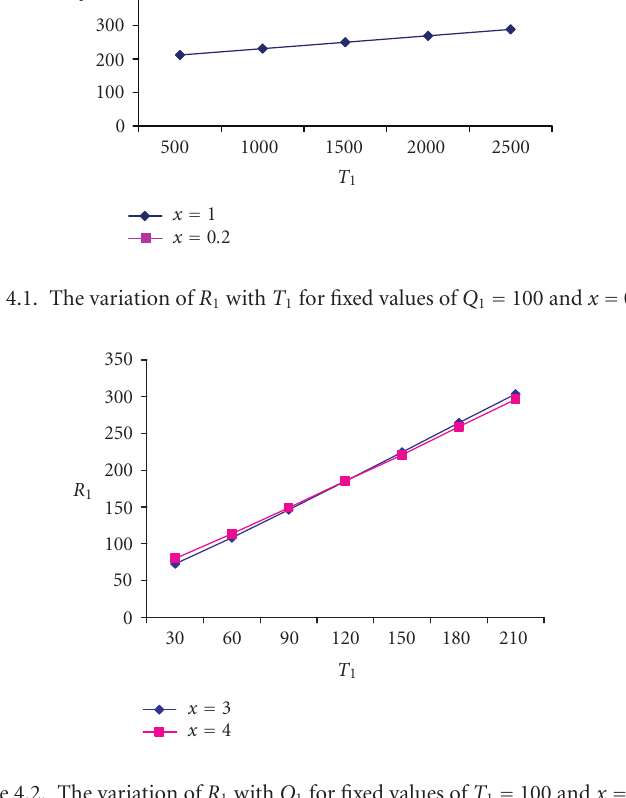
Figure 4.2. The variation of R 1 with Q 1 for fixed values of T 1 = 100 and x =